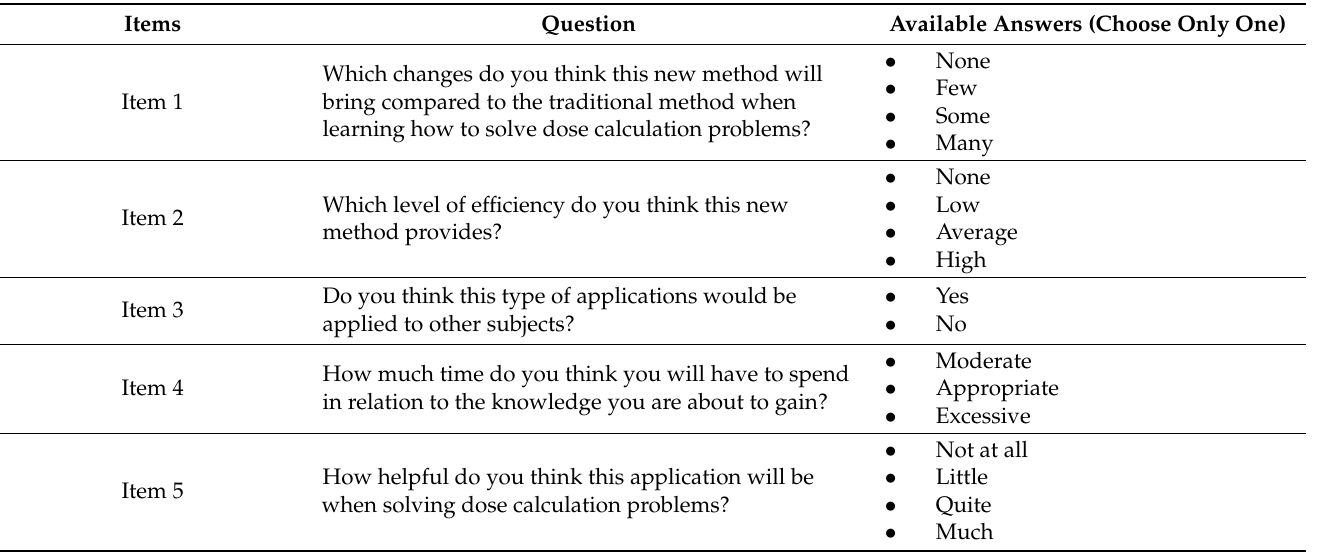
Table 1. Items in the initial survey. Source: Prepared by authors.